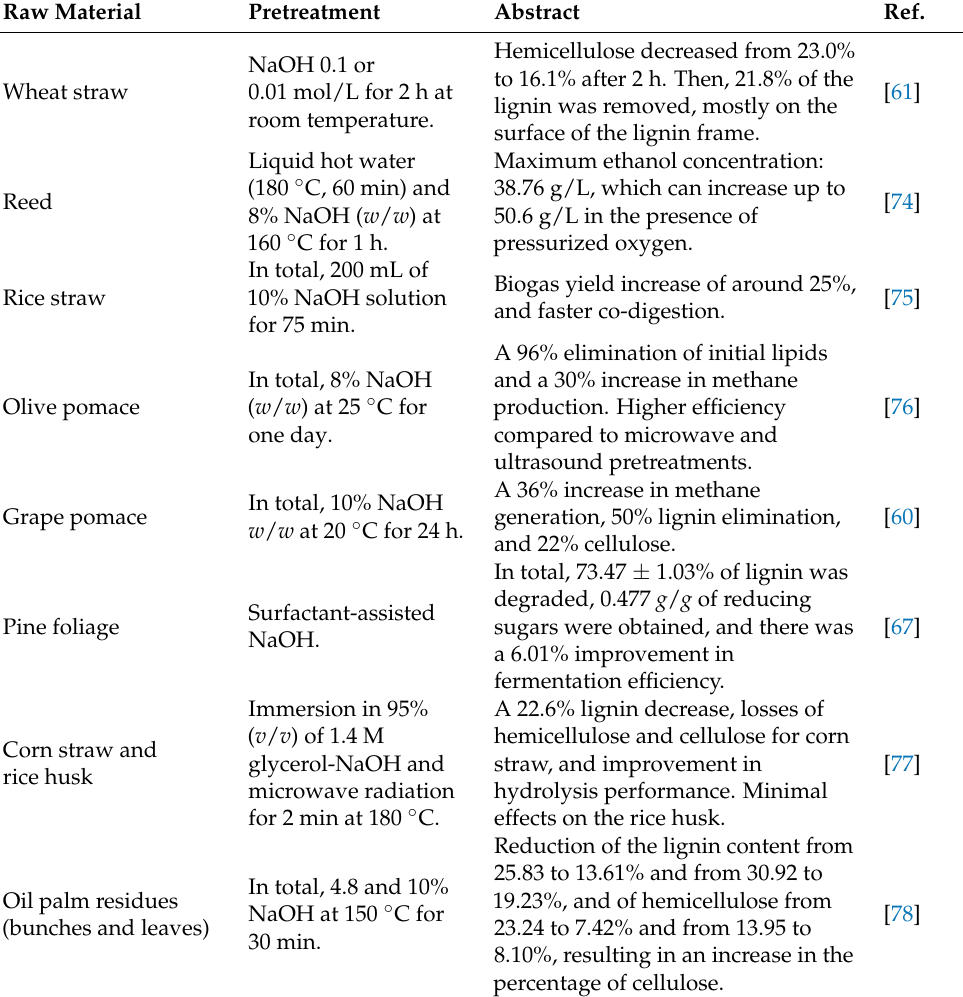
Table 3. Alkaline pretreatments used on different types of